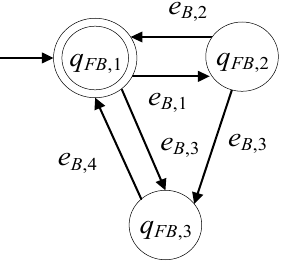
Figure 3. The state diagram of the automaton of the switch including faults.